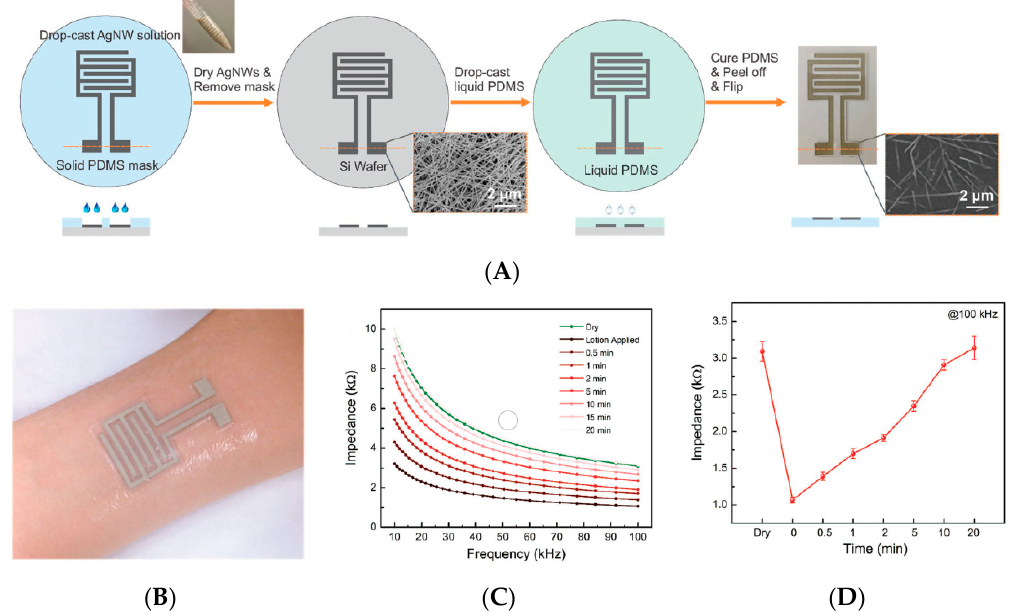
Figure 23. ( A ) Fabrication of the silver nanowires (AgNW)-based sensor, with AgNW network before being embedded into PDMS (left SEM picture) and after embedding (right SEM picture). ( B ) Picture of an AgNW patch placed on the inner side of a forearm. ( C ) Impedance changes from real human skin before and after applying a hydration lotion. ( D ) Skin impedance extracted from (C), at 100 kHz before and after applying the lotion. Reproduced from [70] with permission. © 2017 WILEY-VCH Verlag GmbH & Co. KGaA,